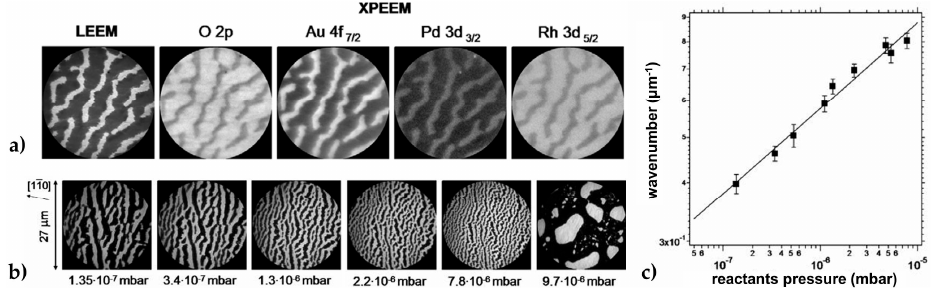
Figure 11. Chemically-frozen phase separation studied by LEEM and XPEEM: ( a ) LEEM and elemental XPEEM of the lamellar structures corresponding to separated Au-Pd and O islands. Conditions of acquisition: T = 820 K, P = 5.3 × 10 − 5 Pa, P H 2 /P O 2 = 0.5, Θ Au+Pd = 0.5 ML; ( b ) LEEM images stationary structures produced under different gas pressures. Conditions of acquisition: T = 820 K, P H / P O = 0.8, Θ Au+Pd = 0.75 ML; ( c ) Plot of the structure wavenumber (in the 2 2 American Chemical